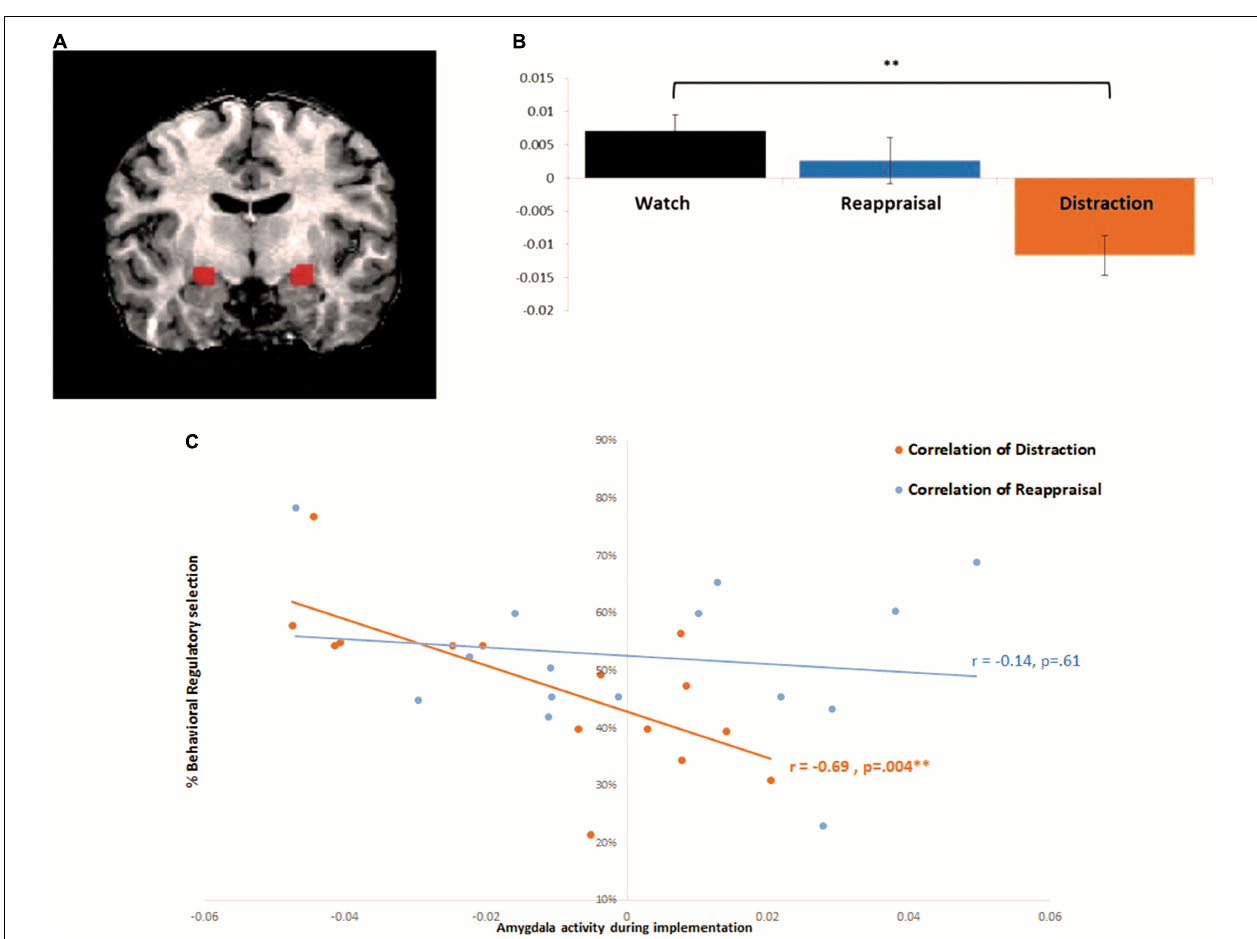
FIGURE 2 | Amygdala activity during implementation correlates with behavioral selection during distraction but not reappraisal: (A) bilateral amygdala functional ROI: active voxels during both Watch > Distraction and Reappraisal (which reflect the reduction of amygdala activity by both ER strategies relative to Watch) were turned into a mask to define the functional region of interest (right: 21 − 12 − 8, left: − 23 − 12 − 7). (B) Beta parameter estimates from the bilateral amygdala (extracted from functional ROI as described in panel A ). Repeated measures ANOVA of Instruction: (Watch, Reappraisal, Distraction) F (2, 28) = 4.837, p = 0.015, and showed significant difference between distraction and watch F (1,14) = 17.73, p = 0.0008. (C) Correlation between amygdala activity and behavioral selection: In orange—correlation between amygdala activity during implementation and behavioral selection of Distraction [Pearson correlation r (15) = − 0.6915, p < 0.005, Bonferroni corrected for multiple comparisons]. In blue—correlation between amygdala activity during implementation and behavioral selection of Reappraisal r (15) = − 0.14, p = 0.6. * p < 0.05, ** p < 0.005, *** p < 0.0005. Error bars represent standard error of